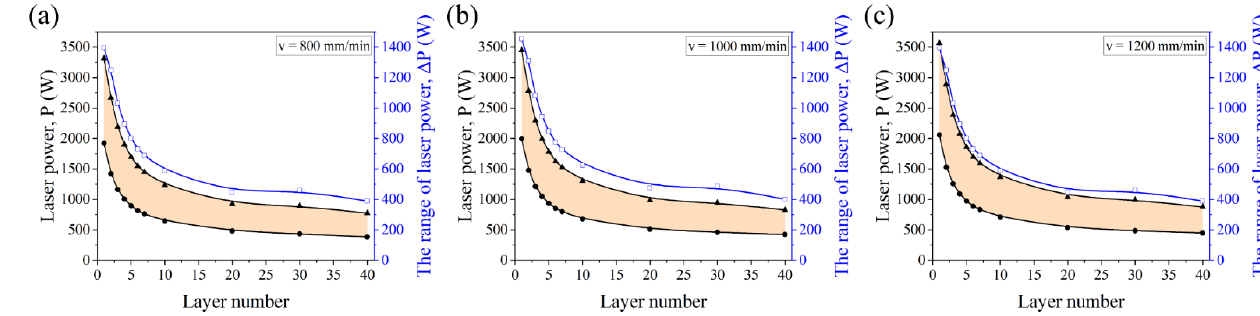
Figure 10. The variation and range of laser power with the layer number at different scanning velocities: ( a ) v = 800 mm/min; ( b ) v = 1000 mm/min, and ( c ) v = 1200 mm/min.